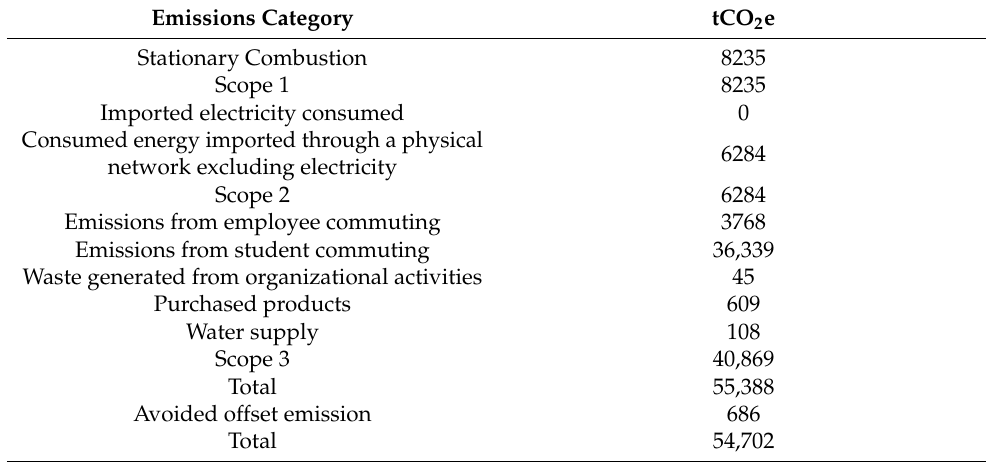
Table 14. Unibo carbon footprint for 2018.